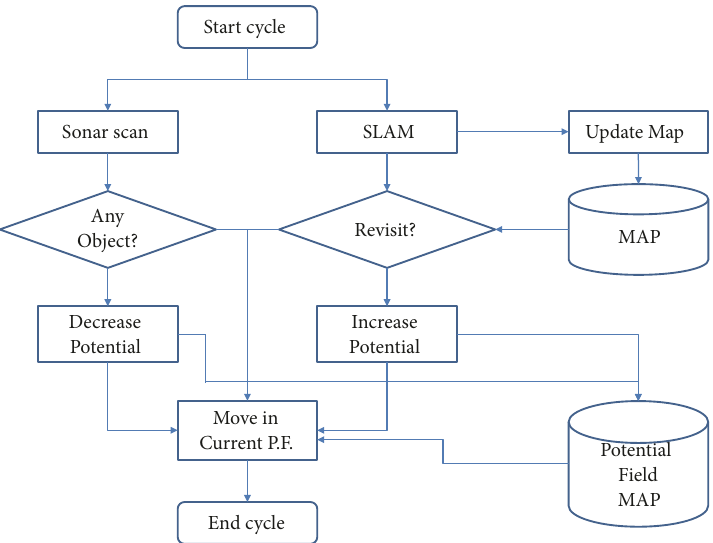
Figure 9: Potential field motion planning.